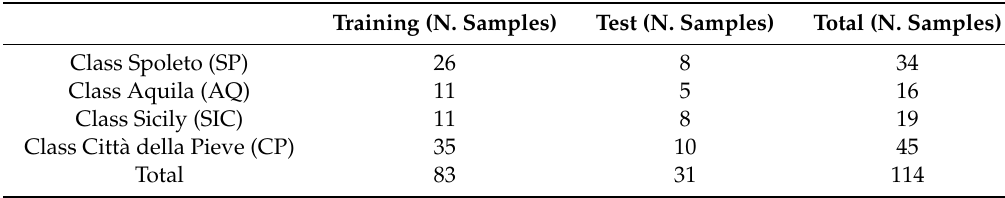
Table 1. Organization of samples into training and test